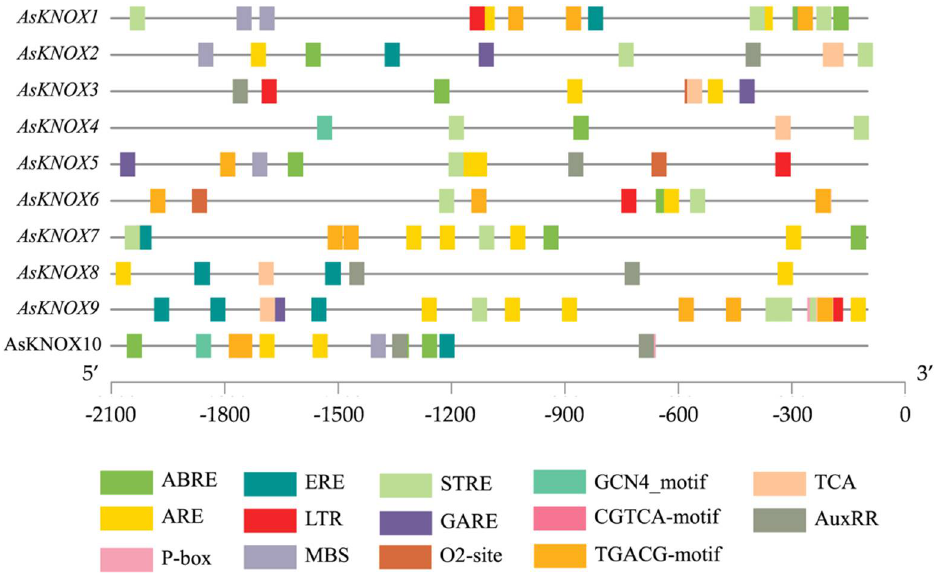
Figure 3. Putative cis-elements in the promoter regions of AsKNOX genes. Different colored rectan- gles denote different cis-elements with various biological functions.